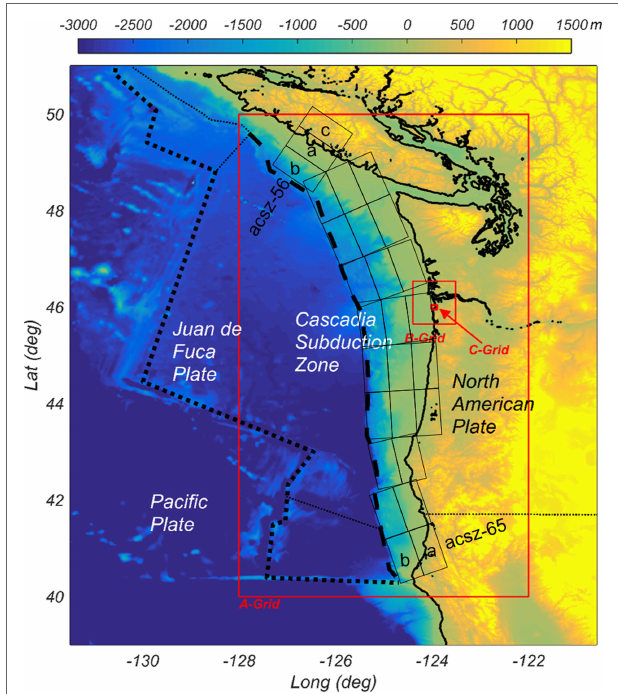
FIGURE 4 | Cascadia subduction zone (CSZ) formed by the Juan de Fuca Plane and the North American Plate. The red boxes indicate the nested grids used in the tsunami modeling. The rectangular boxes along the CSZ show the slip locations used in the tsunami generation model and in the prediction of the ground-motion intensities. The study area of Seaside, Oregon, is located in the C-Grid.